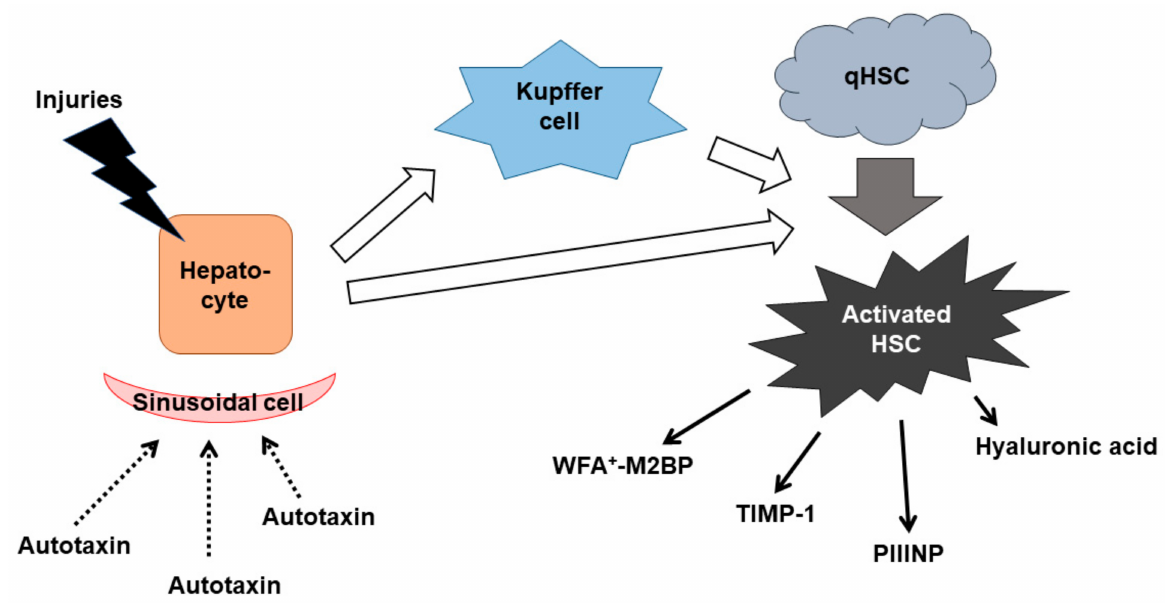
Figure 2. Mechanisms of liver fibrosis with a focus on fibrosis biomarkers.